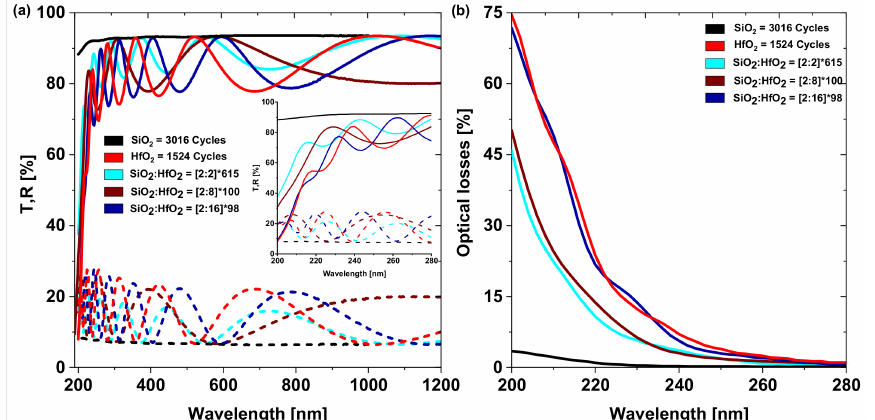
Figure 6. ( a ) Transmittance T (solid curves), reflectance R (dashed curves), and ( b ) optical losses spectra for the SiO 2 :HfO 2 heterostructures with increasing HfO 2